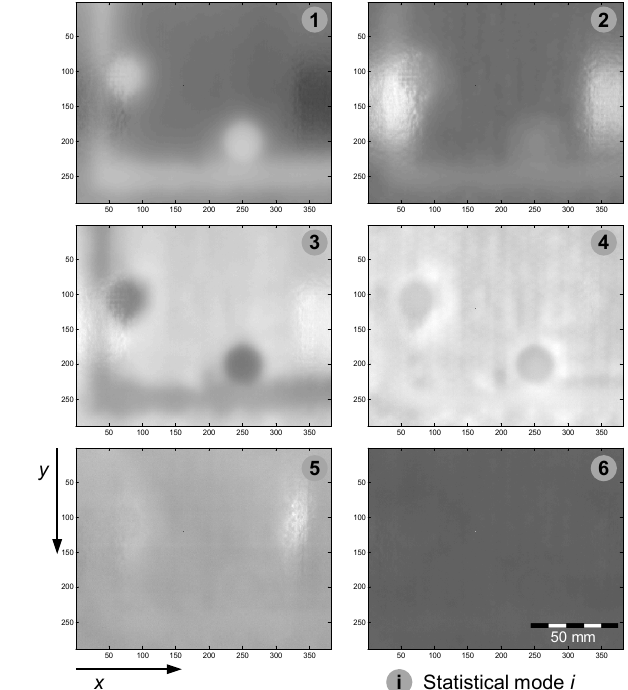
Figure 6. First 6 EOFs of the CFRP specimen.